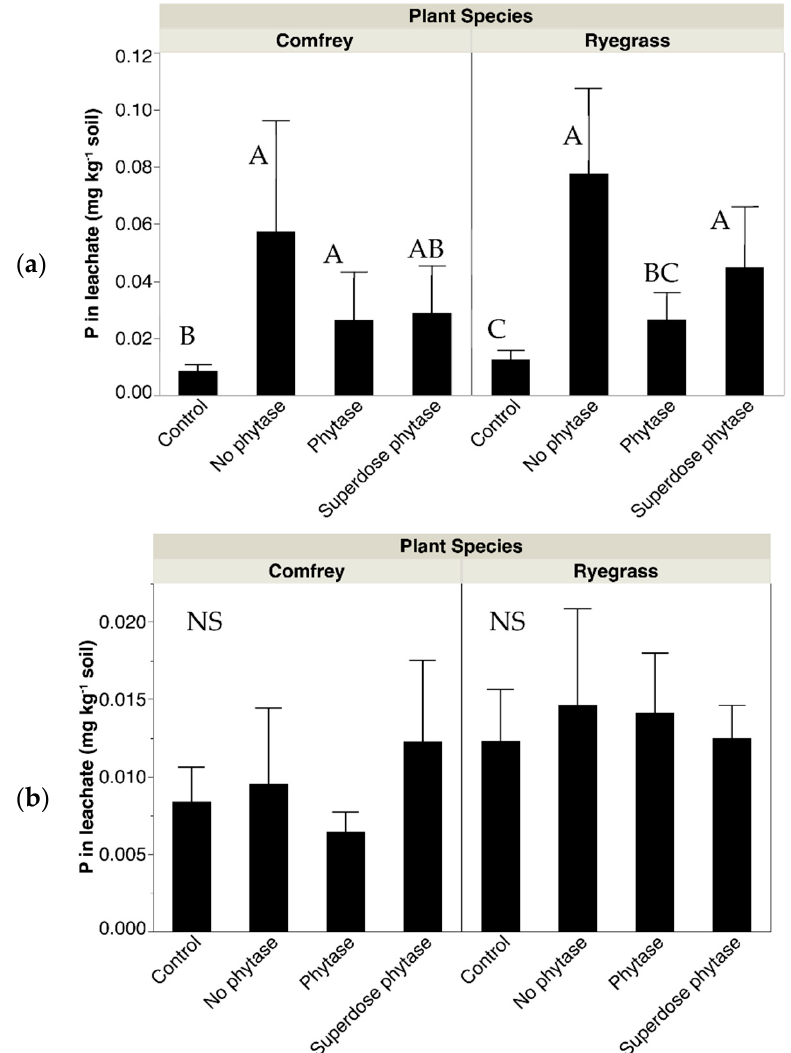
Figure 4. Effects of two different organic amendments ( a ) pig slurry and ( b ) broiler litter from different animal diets on P loss (i.e., WSP) in leachates from experimental pots planted with two different plant species, comfrey ( Symphytum × uplandicum ) and Italian ryegrass ( Lolium multiflorum ). Animal diets include: control = only inorganic fertiliser applied once (i.e., one dose of triple super P initially applied to support seedling growth), no-phytase, phytase and superdose phytase. Different letters indicate significant differences among treatments (Tukey HSD test).